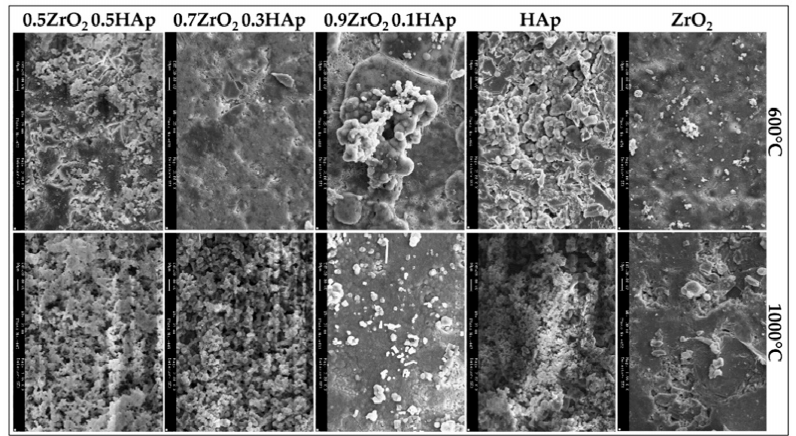
Figure 2. SEM micrographs of composite coated samples heated to 600 ◦ C and 1000 ◦ C after 21 days of exposure to simulated body fluids (SBF) with different compositions [62].